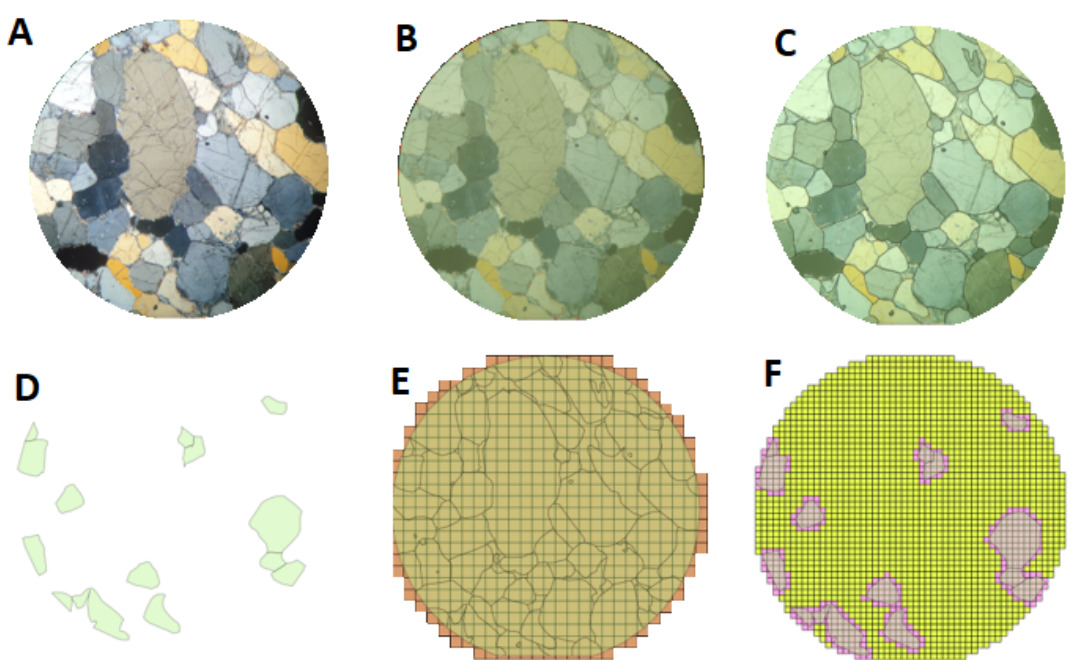
Figure 2. Example of counting crystal boundary contour process: image taken from the microscope camera ( A ), marking the field of the study area ( B ), sharpening the boundaries of the crystals ( C ), identifying and selecting the mineral crystals for analysis ( D ), applying a grid for counts ( E ), determining those grid areas that form the boundaries of the selected crystals ( F ).